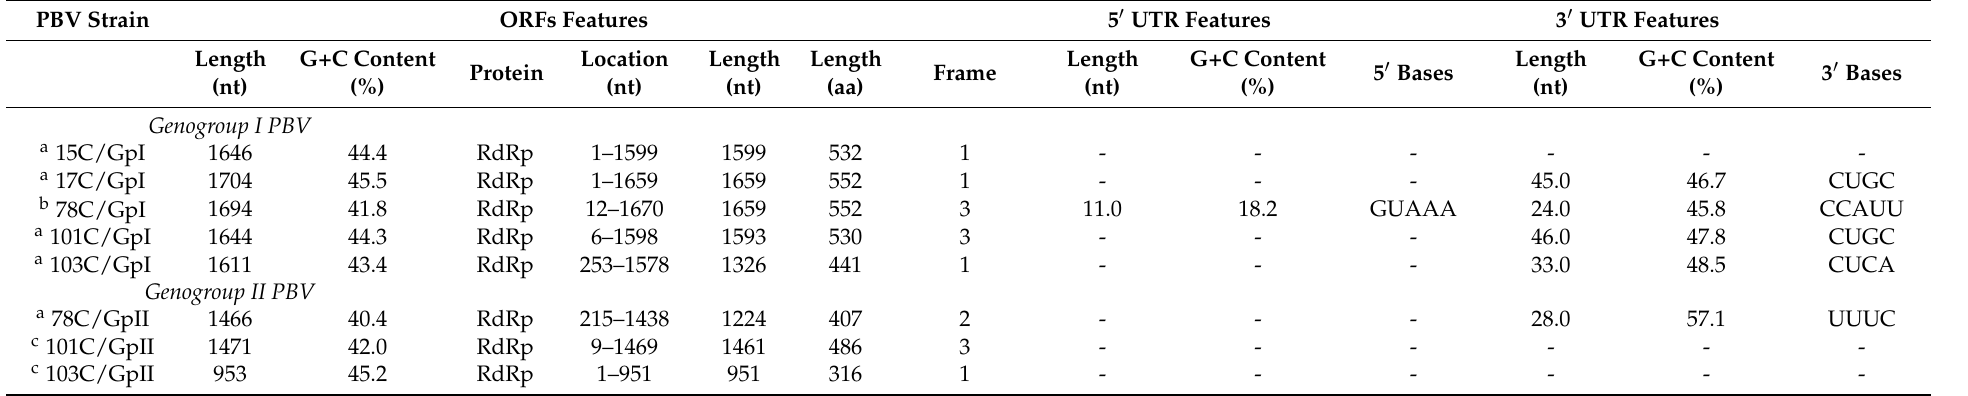
Table 4. Genomic features of segment 2 sequences of genogroup I and genogroup II PBVs from dromedary fecal samples. PBV